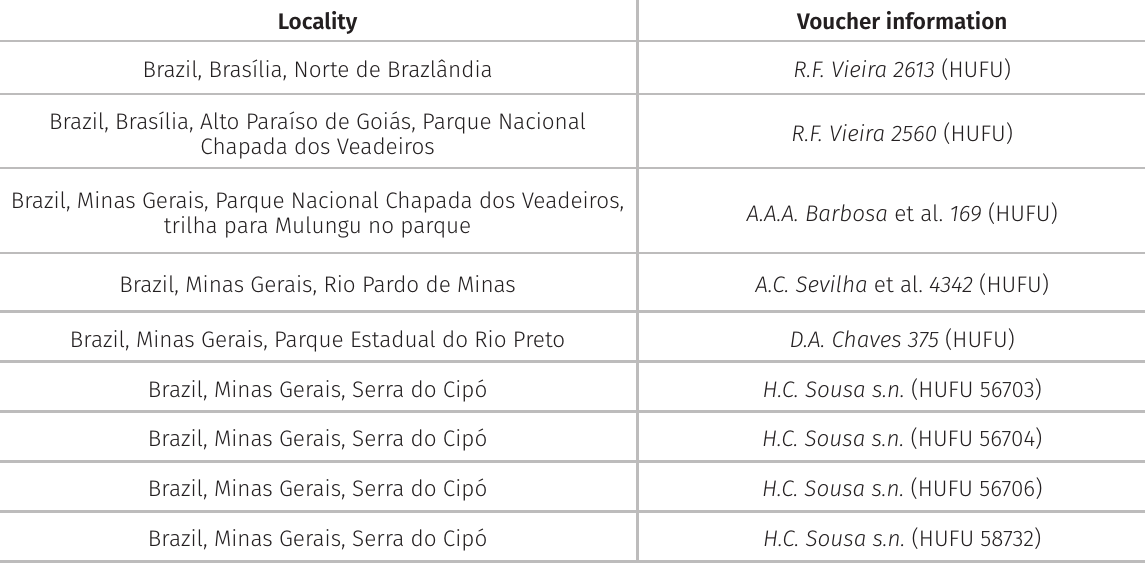
Table I. List of Lychnophora salicifolia specimens examined.